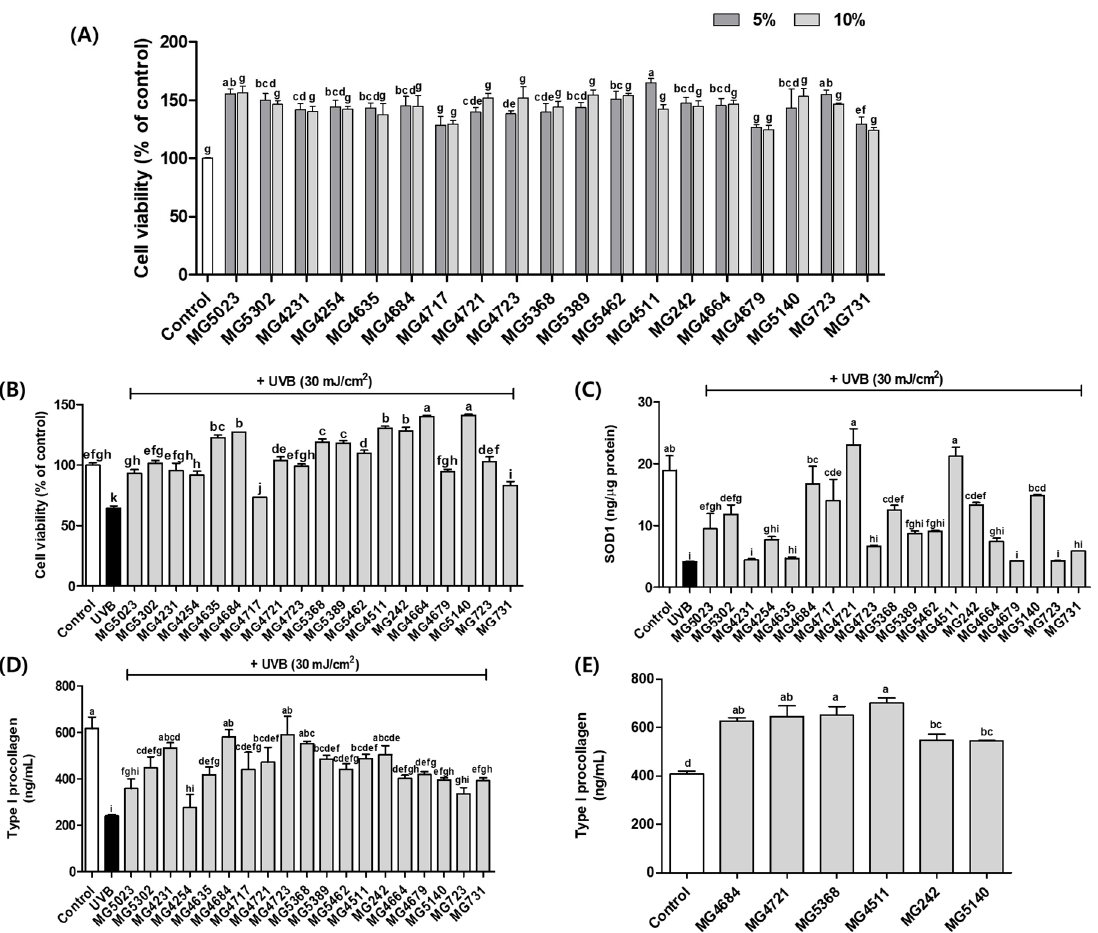
Figure 1. Effect of CFS from LAB strains on cell viability without UVB ( A ) or with UVB ( B ), SOD1 level ( C ), and type I procollagen level without UVB ( D ) or type I procollagen level with UVB ( E ). Data represent the mean ± SEM ( n = 3). Different letters indicate significant difference between means at p < 0.05 by Duncan’s multiple range test.